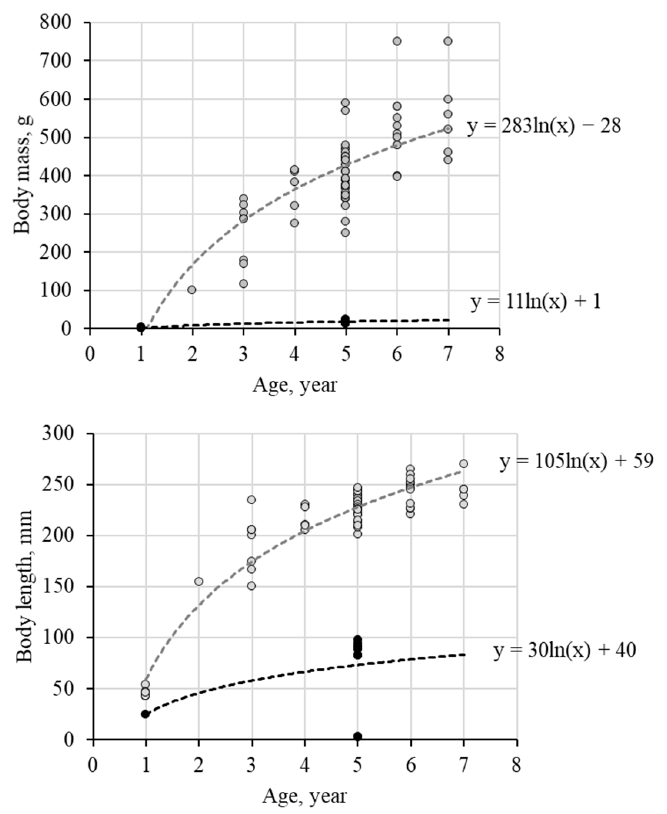
Figure 4. The growth rate of crucian carp in the studied reservoirs in terms of weight and body length (light circles—fish from Chany Lake, black—from Komsomolsk pond).